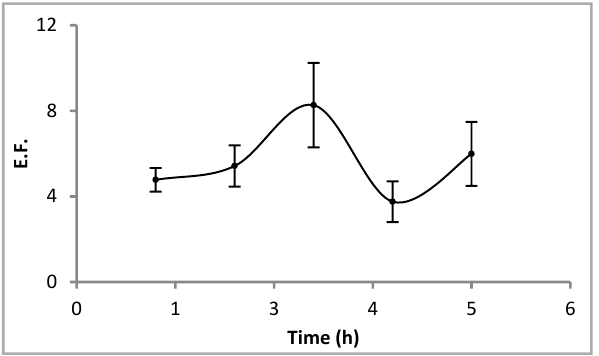
Figure 2. Effect of extraction time on the enrichment factor. Sample: 0.1 µg L −1 Cd 2+ in NaNO 3 1 M and HEPES 0.1 M. Liquid membrane: Cyanex ® 272 1 M in dihexyl ether. Acceptor solution: HNO 3 1 M. Fibre length: 10 cm. Stirring rate: 200 rpm.